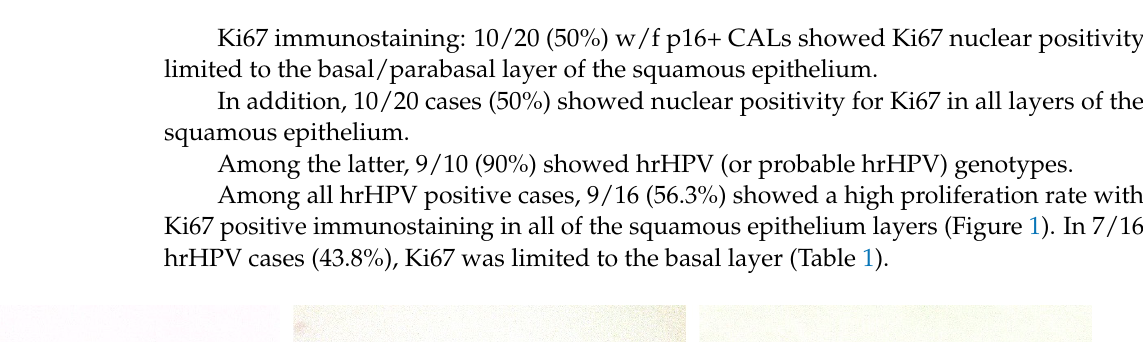
*p16: w/f = weak and focal immunostaining pattern; neg = negative immunostaining pattern; **Ki67: 1 = positive nuclear immunostaining in basal layers of squamous epithelium; 2 = positive nuclear immunostaining in all the squamous epithelium layers.